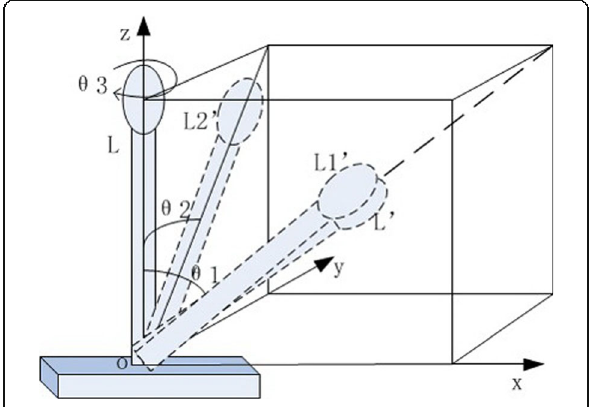
Fig. 2 Kinematical diagram of the designed haptic device